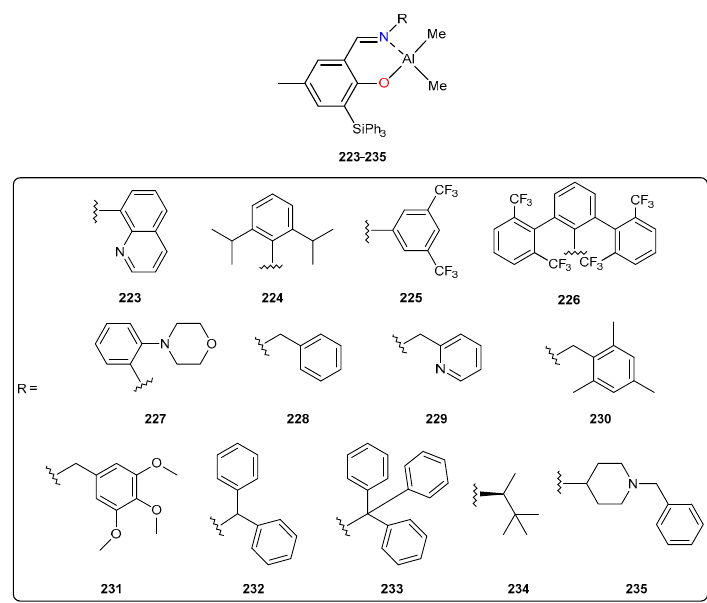
Figure 37. Ortho -triphenylsilyl substituted complexes 223–235 [114].